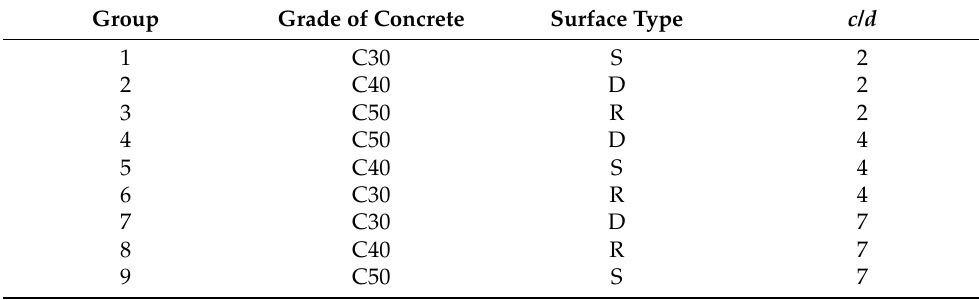
Table 3. Details of